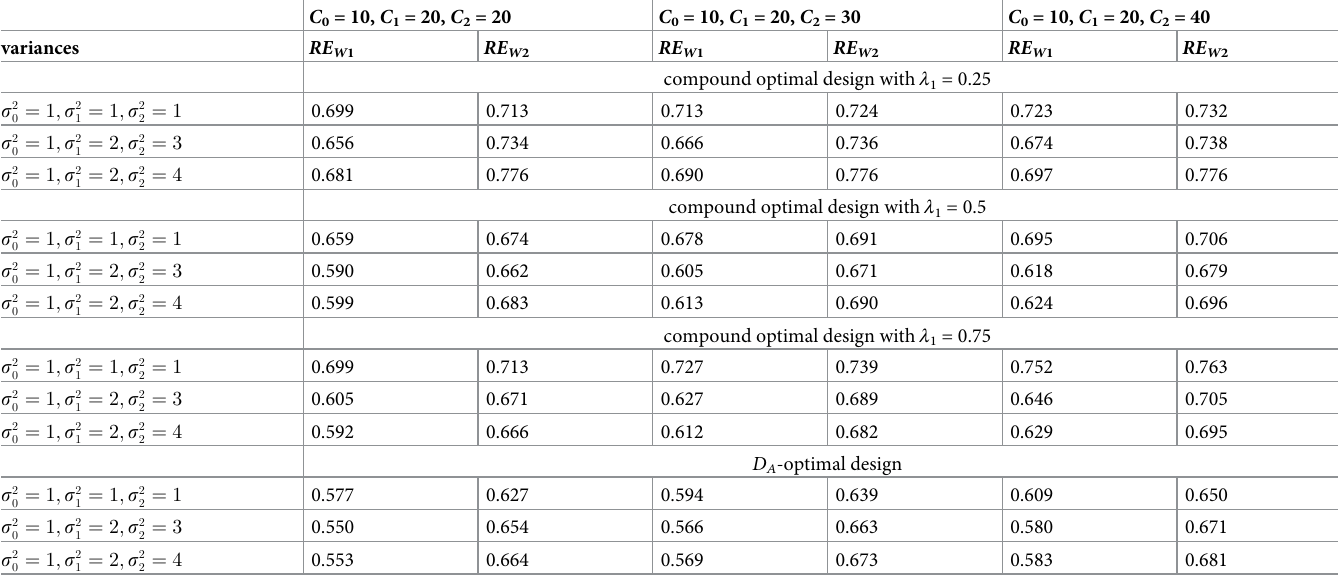
Table 4. Efficiency of the incomplete within–subject design relative to the complete within–subject